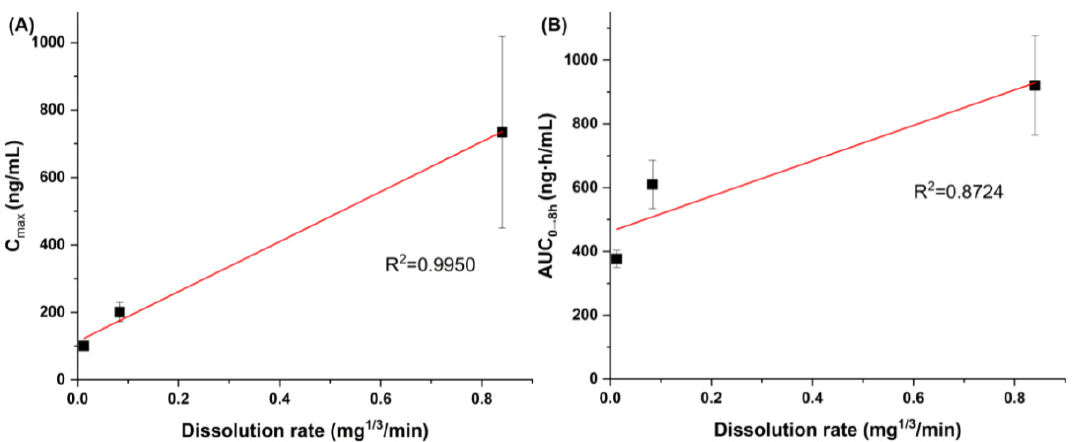
Figure 6. Correlation between the in vitro dissolution rate and in vivo pharmacokinetic data of trans -resveratrol: ( A ) in vitro dissolution rate vs. in vivo C max ; ( B ) in vitro dissolution rate vs. in vivo AUC 0–8 h .